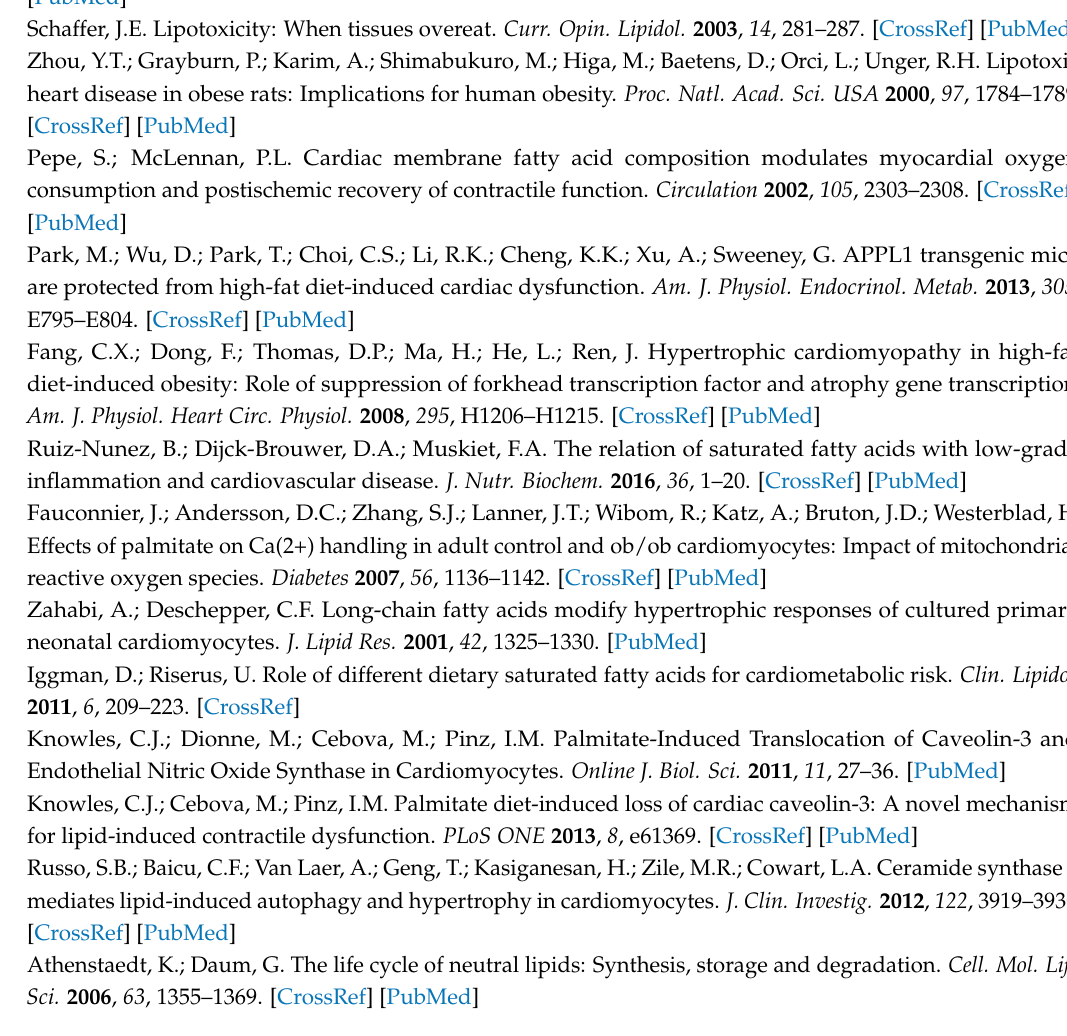
Table S1: Fatty acids composition of experimental diets, Table S2: Body weight and heart weight of mice at 3 and 6 months of feeding regimen, Table S3: Metabolic parameters of mice fed high fat diets for 3 months, Table S4: Relevant parameters for cardiac function results from mice fed high fat